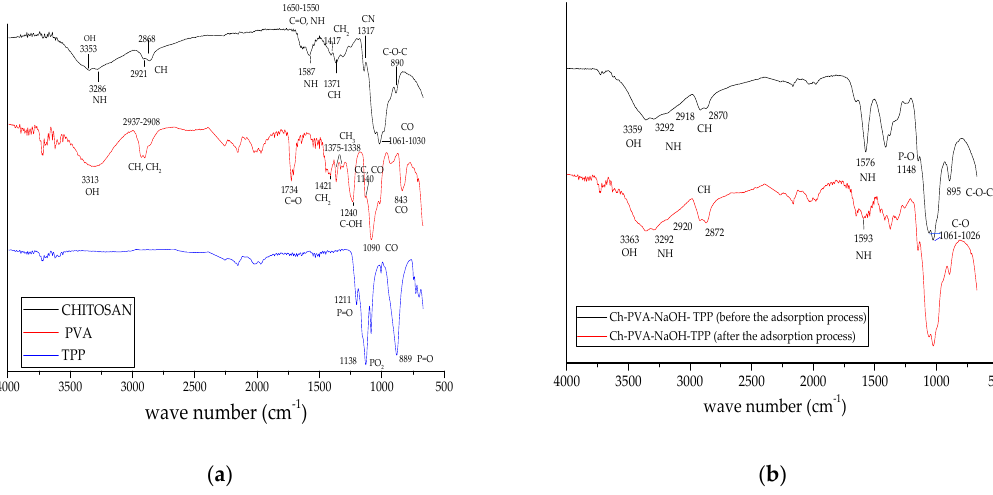
Figure 2. ( a ) FTIR spectra of chitosan-polyvinyl alcohol (Ch-PVA), and tripolyphosphate pentabasic (TPP); ( b ) FTIR spectra of Ch-PVA-NaOH-TPP before and after adsorption.